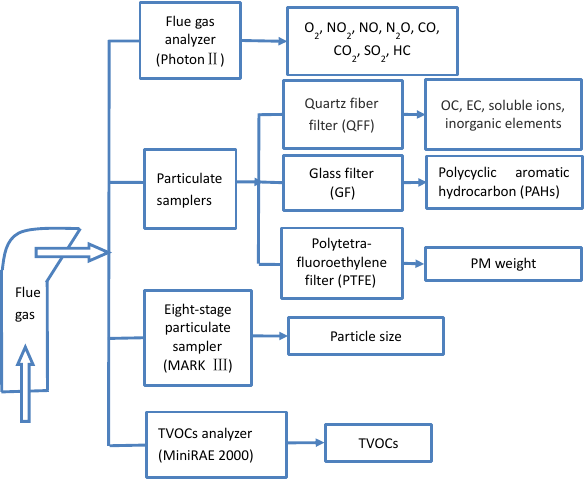
Figure 1. On-board emissions test system and measured analytes.